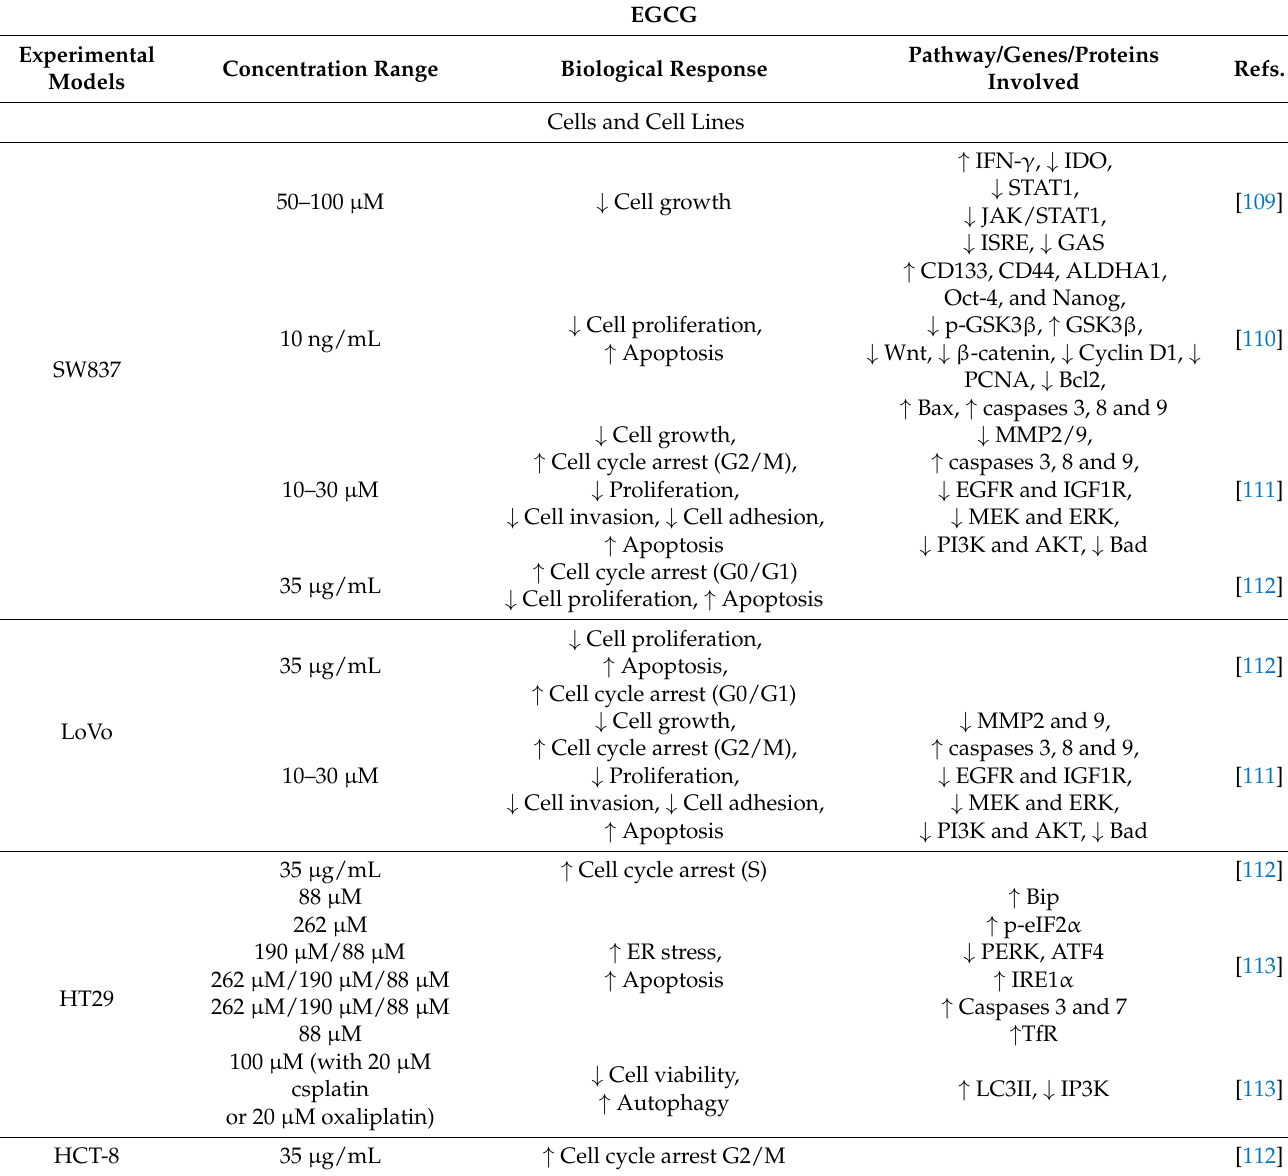
Table 6. Antitumoral effects of EGCG in colorectal